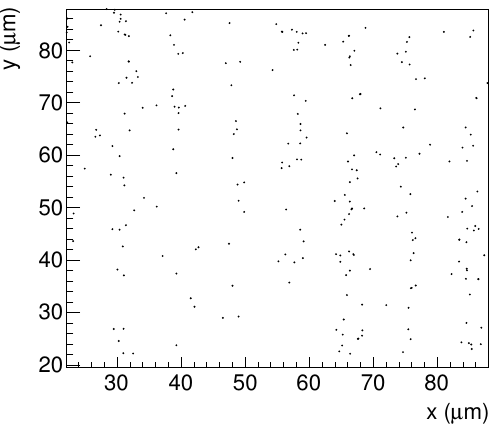
Figure 5. Starting points of tracks on the surface of the substance.